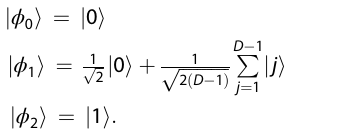
Picture 1: fi xed ground